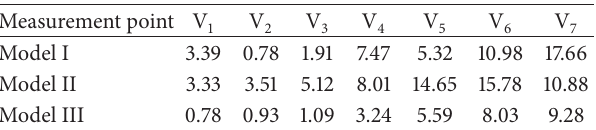
for base excitation at 𝑓 1